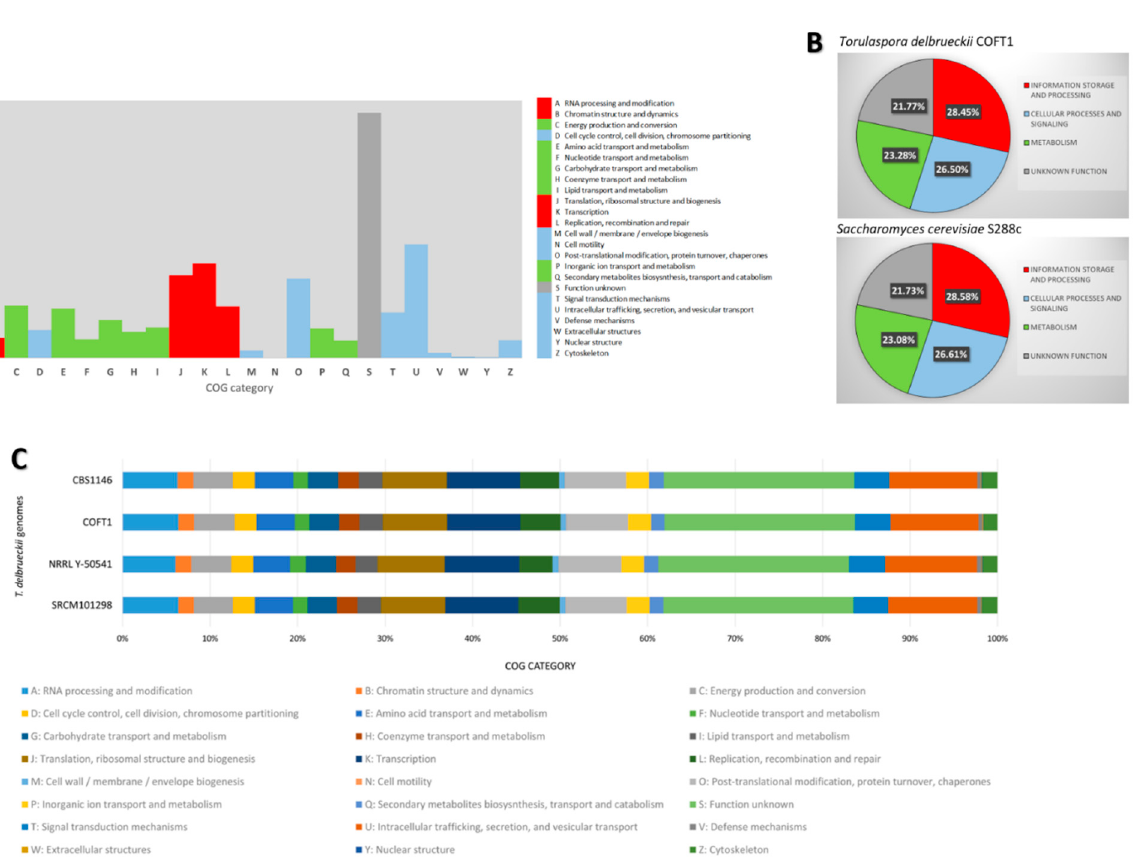
Figure 3. eggNOG classifications of the annotated T. delbrueckii genes. The functional annotations were divided into 24 categories, corresponding to clusters of orthologous groups (COGs). ( A ) Number of genes grouped in each of the 24 COG categories for the T. delbrueckii COFT1 genome. The colors are indicative of the functional categories used in panel B. ( B ) Classification of the genes into functional categories, comparing T. delbrueckii COFT1 with the reference S. cerevisiae S288c. ( C ) Comparison between the four available genomes of T. delbrueckii in terms of the number of grouped genes (as a percentage) in each COG category.